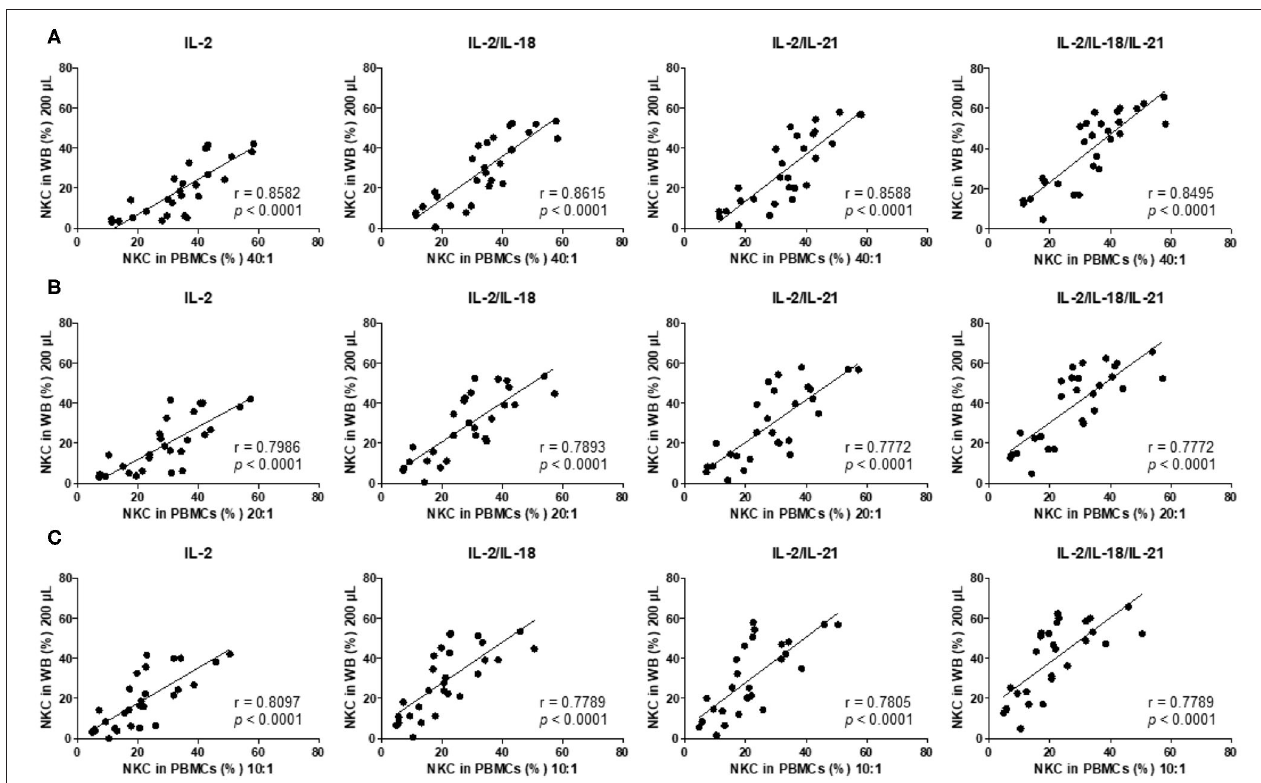
FIGURE 4 | NK cytotoxicity correlations between peripheral blood mononuclear cells (PBMCs) and overnight cytokine-activated whole blood (WB) assays. Natural killer (NK) cytotoxicity assays were performed using PBMCs at an E:T ratio of (A) 40:1, (B) 20:1, and (C) 10:1 and 200 µ L WB ( n = 28 donors). Correlation between PBMCs and IL-2-, IL-2/IL-18-, IL-2/IL-21-, and IL-2/IL-18/IL-21-treated WB. ( Figure 3A ). We confirmed that three kinds of donors with cytotoxicity assay, whereas overnight WB NK cells activated by all low, medium, and high NK cytotoxicity in the PBMC assay other combinations (IL-2/IL-18, IL-2/IL-21, and IL-2/IL-18/IL- demonstrated the same pattern of cytotoxicity in the WB assay, 21) demonstrated similar cytotoxicity. Among these, the IL-2/IL- and this pattern was not disturbed by the type of cytokine 18/IL-21-activated WB NK cells had the highest cytotoxicity